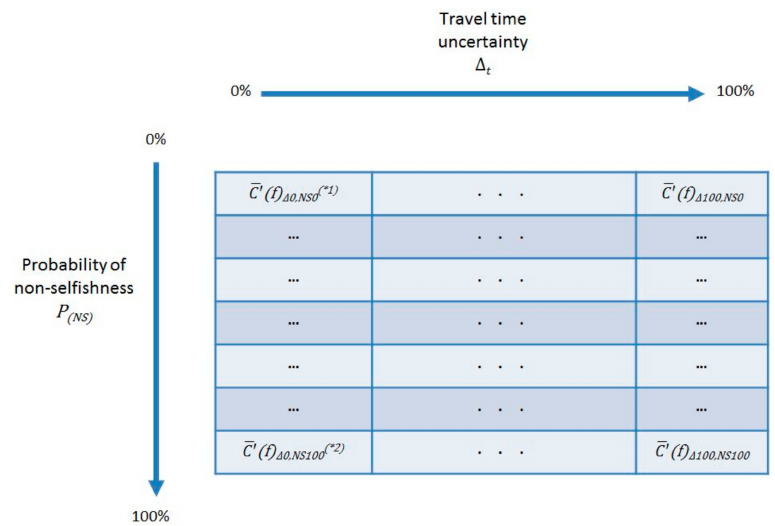
Figure 3. Overview of the methodology to quantify the impact of cognitive agents, levels of selfishness and uncertainty on routing for a group of